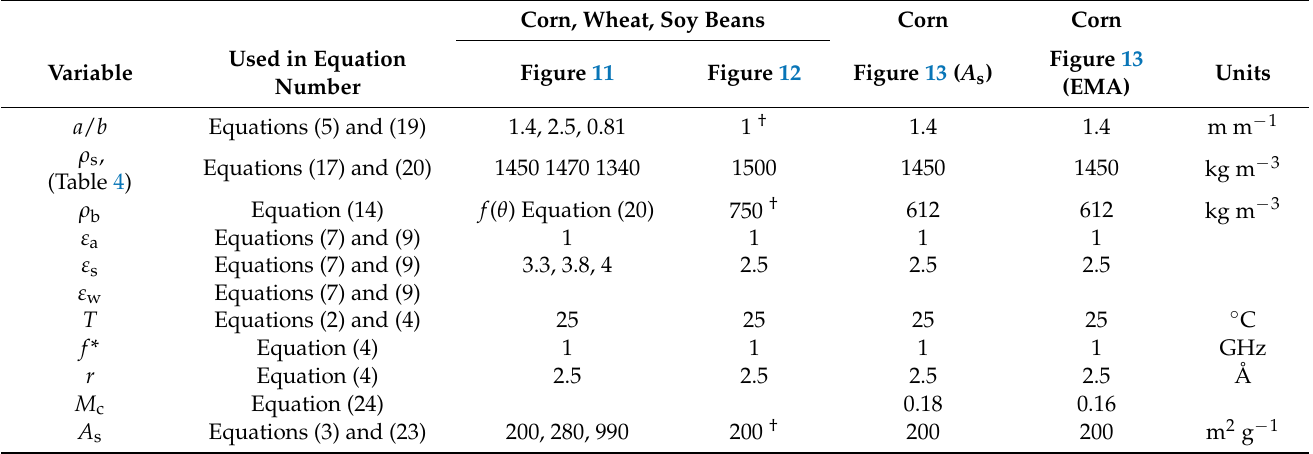
Table 8. Equation variables used for modeling permittivities plotted in Figures 11–13. Corn, Wheat, Soy Beans Corn